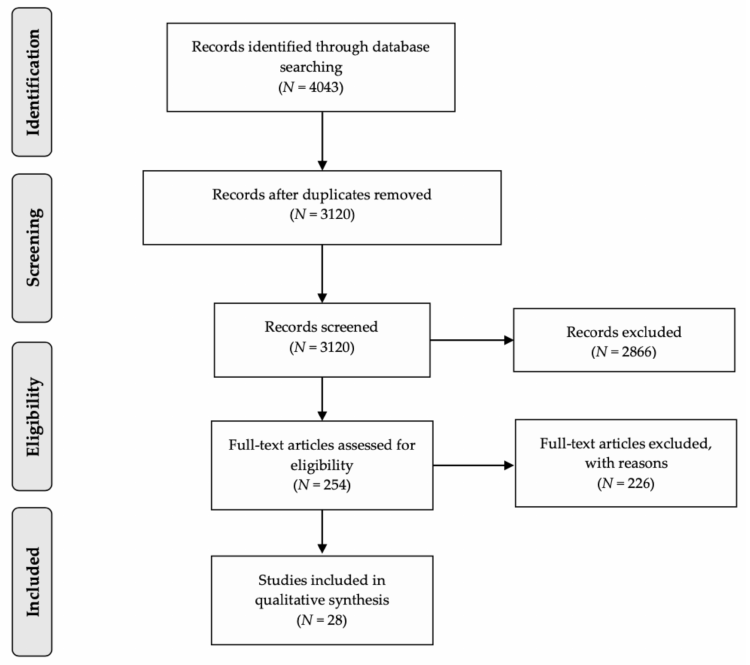
Figure 1. Preferred Reporting Items for Systematic Reviews and Meta Analyses flow